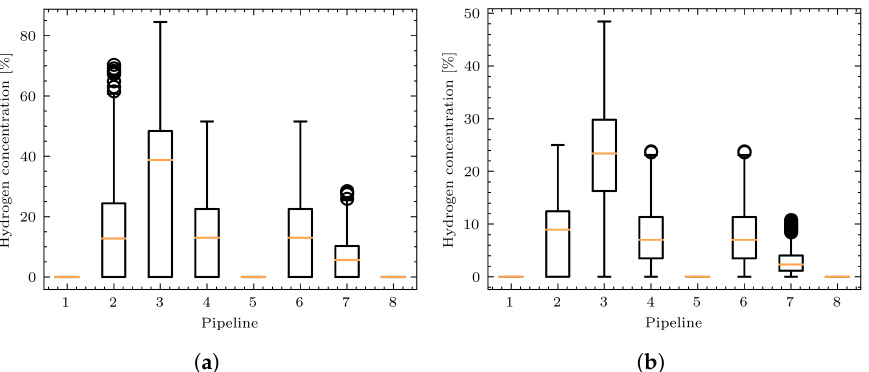
Figure 11. ( a ) Hydrogen concentration in pipelines in June. ( b ) Hydrogen concentration in pipelines in December.